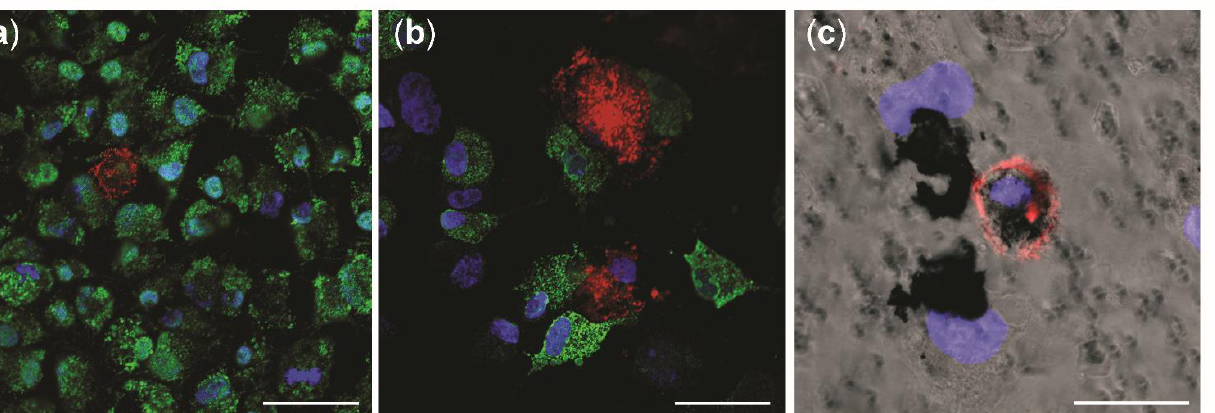
Figure 7. Confocal microscopy investigation of tricultures with and without NM-300K exposure. Confocal pictures show the apical side of triculture model in ( a ) negative incubator control, and ( b , c ) after exposure to NM-300K at 10 µ g/cm 2 . A549 cells were stained with pro-surfactant protein C (green) and dTHP-1 are marked with CD11b (red). DNA is stained with DAPI (blue). ( c ) Phase contrast picture combined with immunofluorescence staining. ( a – c ) Magnification: 40 × . Scale bar: 50 µ m ( a , b ); 20 µ m ( c ).